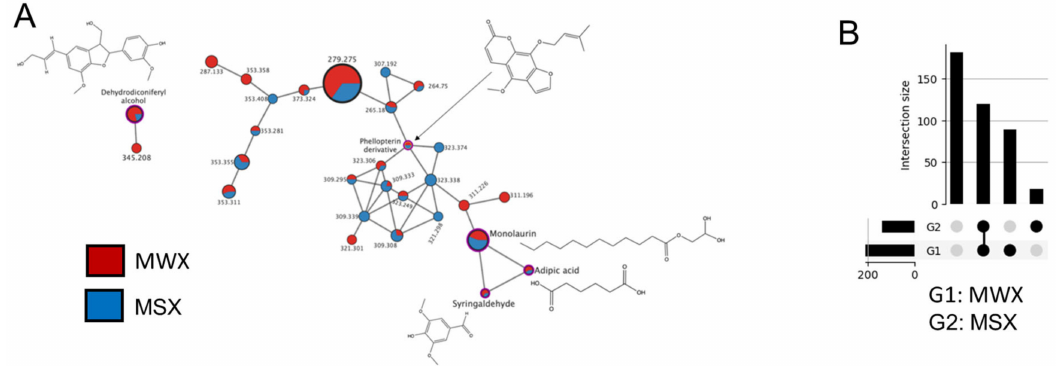
Figure 4. ( A ) An LC-MS/MS-based molecular network of chemicals from MSX and MWX using the GNPS platform and Cytoscape. Red nodes represent compounds present in MWX, while blue nodes represent compounds present in MSX. Compounds present in both extracts (red and blue) are shown in pie percentages out of a total quantification (100%) in both extracts. The size of each node is relative to the quantification amount of each compound based on ion count. Five total compounds were able to be dereplicated through molecular networking: dehydrodiconiferyl alcohol, a phellopterin analogue, monolaurin, adipic acid (adipate), and syringaldehyde. ( B ) UpSet plot detailing unique metabolite features found in MWX (G1) and MSX (G2). Intersection size shows the features attributable to each sample or found in both